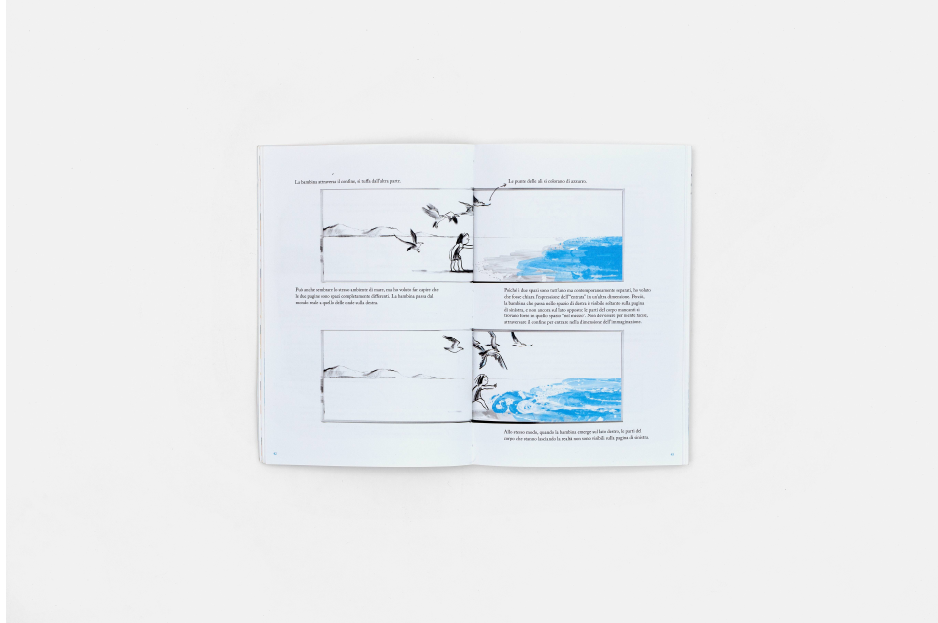
Figure 8. Lee S. (2012), La trilogia del limite , Corraini, Mantua.